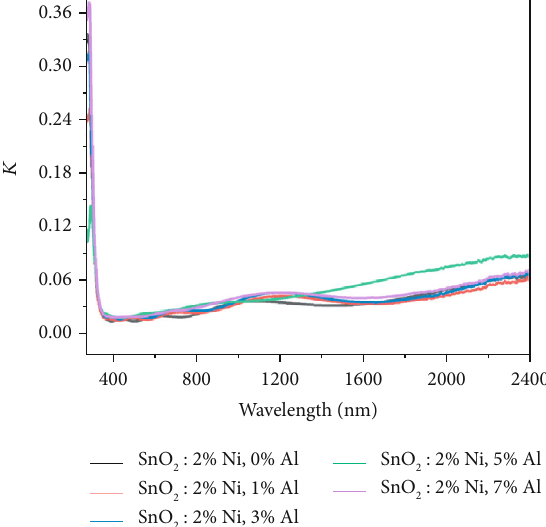
thin fi lms as a function of the aluminum concentration. 2